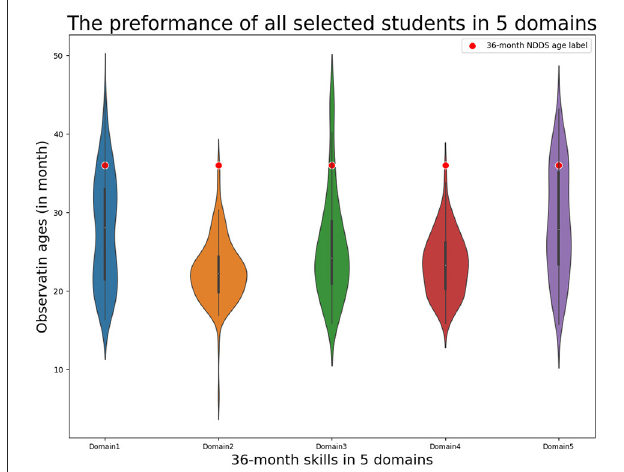
FIGURE1 Violin plots of 36-month skills observation ages against NDDS age label.